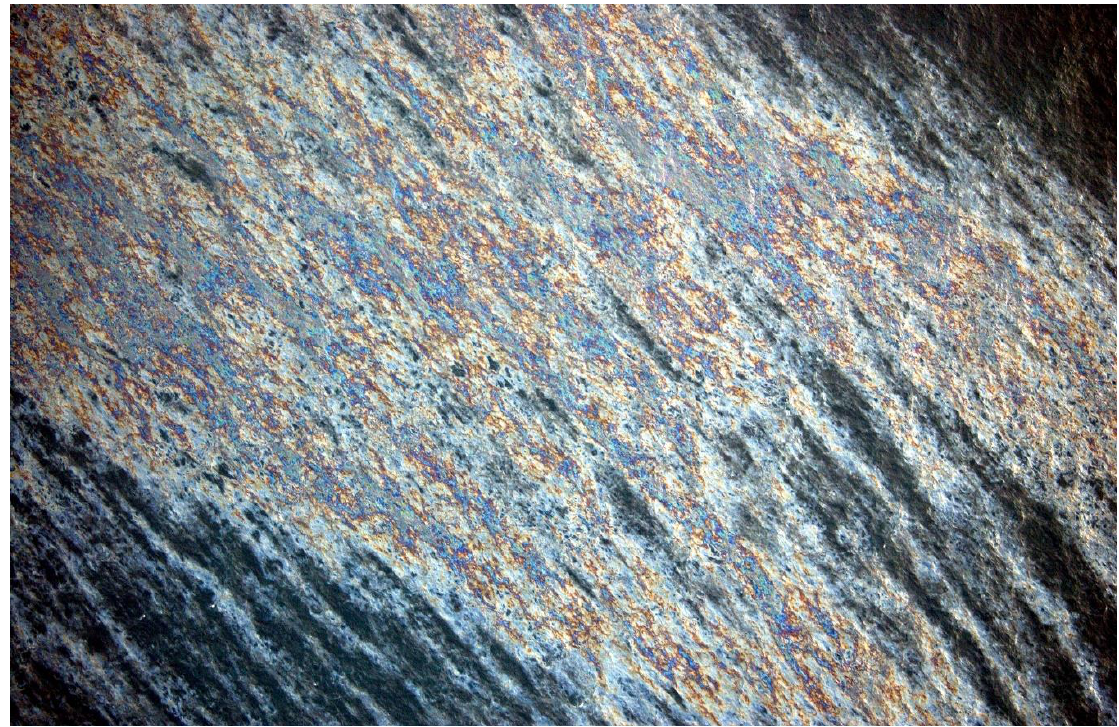
Figure 7. A fresh discharge from a vessel which has a rainbow color appearance.